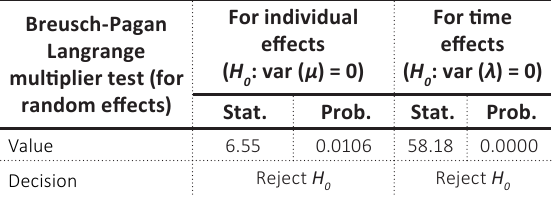
Table 7. Breusch-Pagan LM test results for random effects